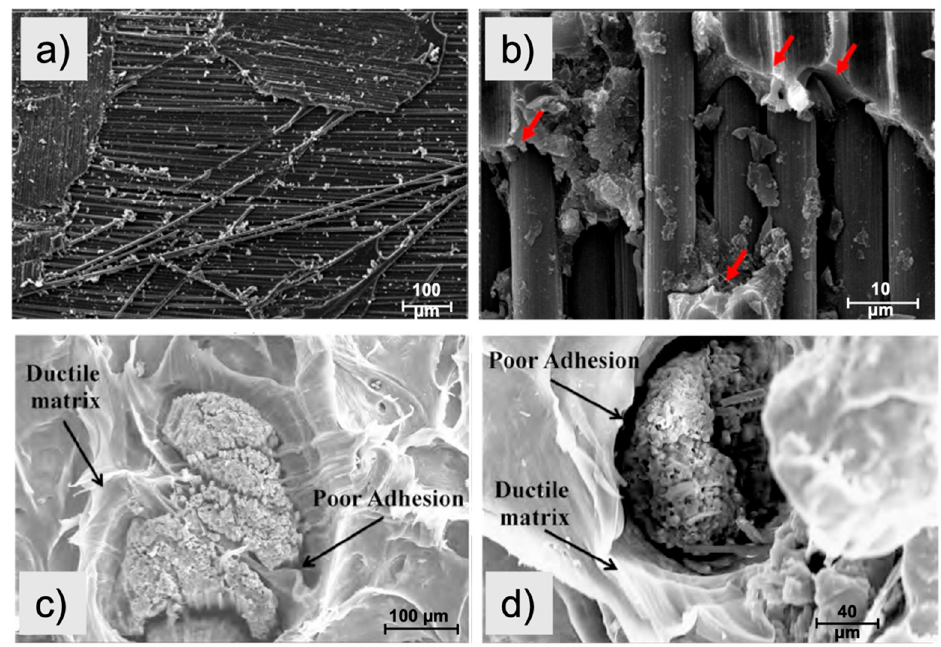
Figure 3. SEM images of the recycled carbon fibers: ( a , b ) poor epoxy-rCF interface [60]; ( c , d ) poor adhesion between the PP matrix and rCF [61]. adhesion between the PP matrix and rCF